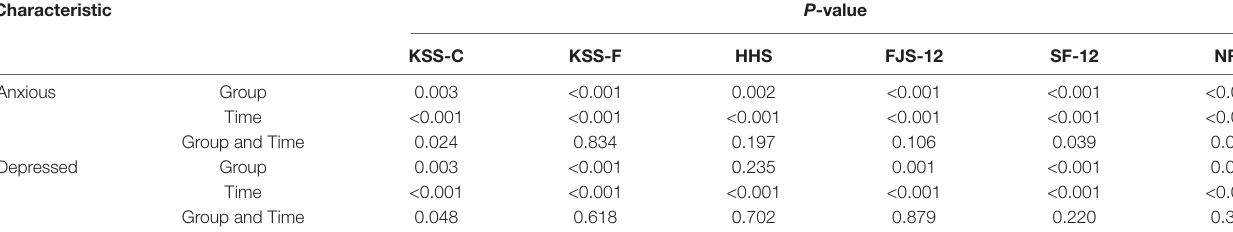
N: asymptomatic patients; Y: symptomatic patients. TABLE 4 | Repeated measures multivariate analysis of variance results. Characteristic P -value